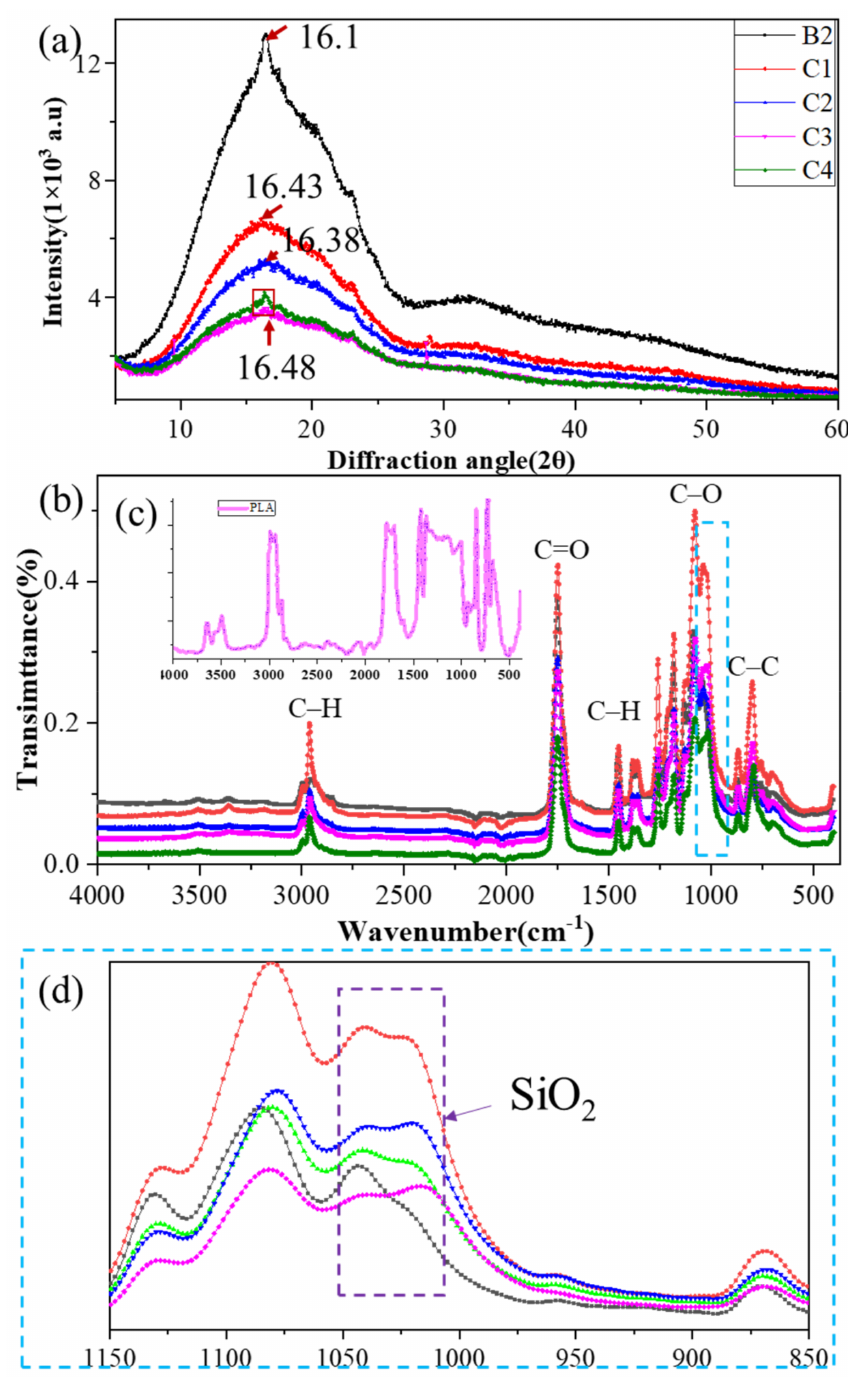
Figure 3. The structural characterizations of group C: ( a ) WAXS, ( b ) FTIR, ( c ) is the FTIR of PLA and ( d ) is the enlarged view of the blue area in ( b